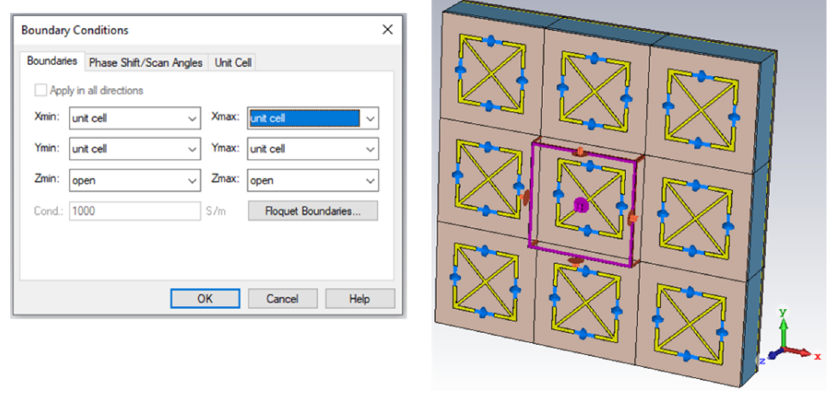
Figure 2. Boundary setup in CST.